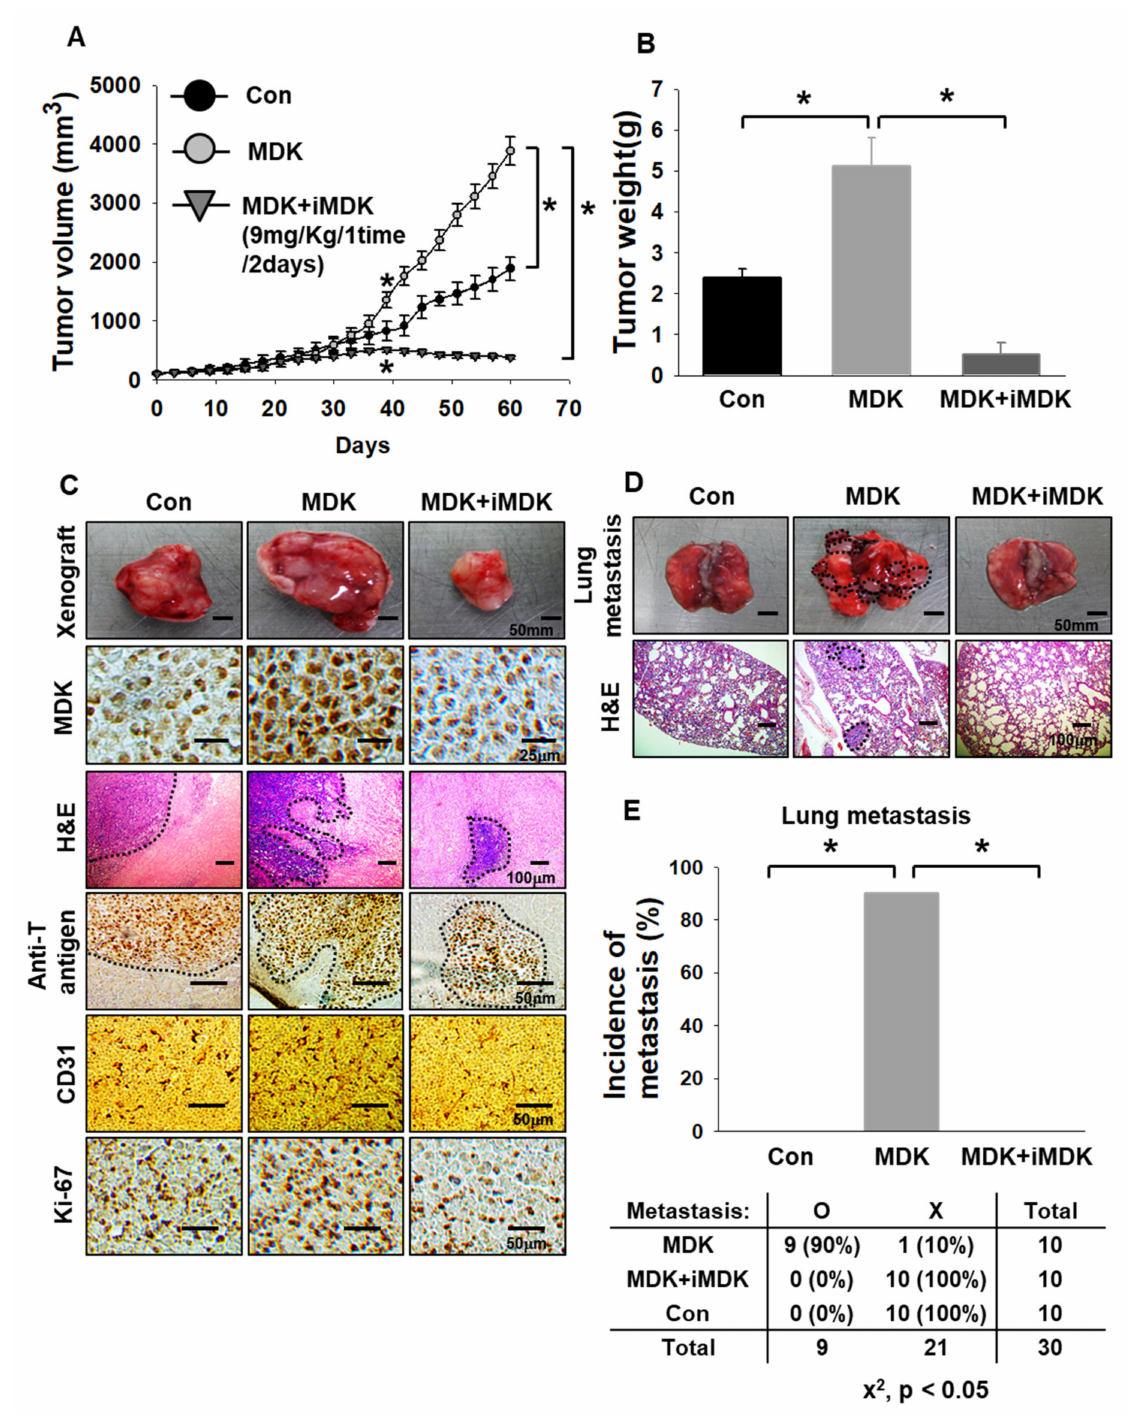
Figure 5. MDK inhibitor exhibits anti-tumor and anti-metastasis e ff ects on a xenograft mouse model of NSCLC. ( A ) H1299 cells were transfected with E.V. and Myc-DDK-MDK, which were selected by G418 (400 µ g / mL) until colony formation. H1299 cells were injected subcutaneously into nude mice 1 × 10 6 cells / mouse, and tumor formation was measured every 3 days for 60 days from day 7 after implantation. Groups were intraperitoneally treated: DMSO (100 µ L / 1 time / 2 days) in the control and iMDK (9 mg / kg / 1 time / 2 days) in the drug treated-groups. Student’s t test was performed and values displayed as average ± SEM; n = 10, * p < 0.05. ( B ) Tumor weight was measured after removal. Student’s t test was performed and values displayed as average ± SEM; n = 10, * p <